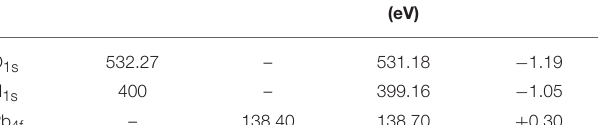
TABLE 1 | Electron binding energies of different elements of BHA and Pb-BHA complexes. Elements BHA binding energy (eV)